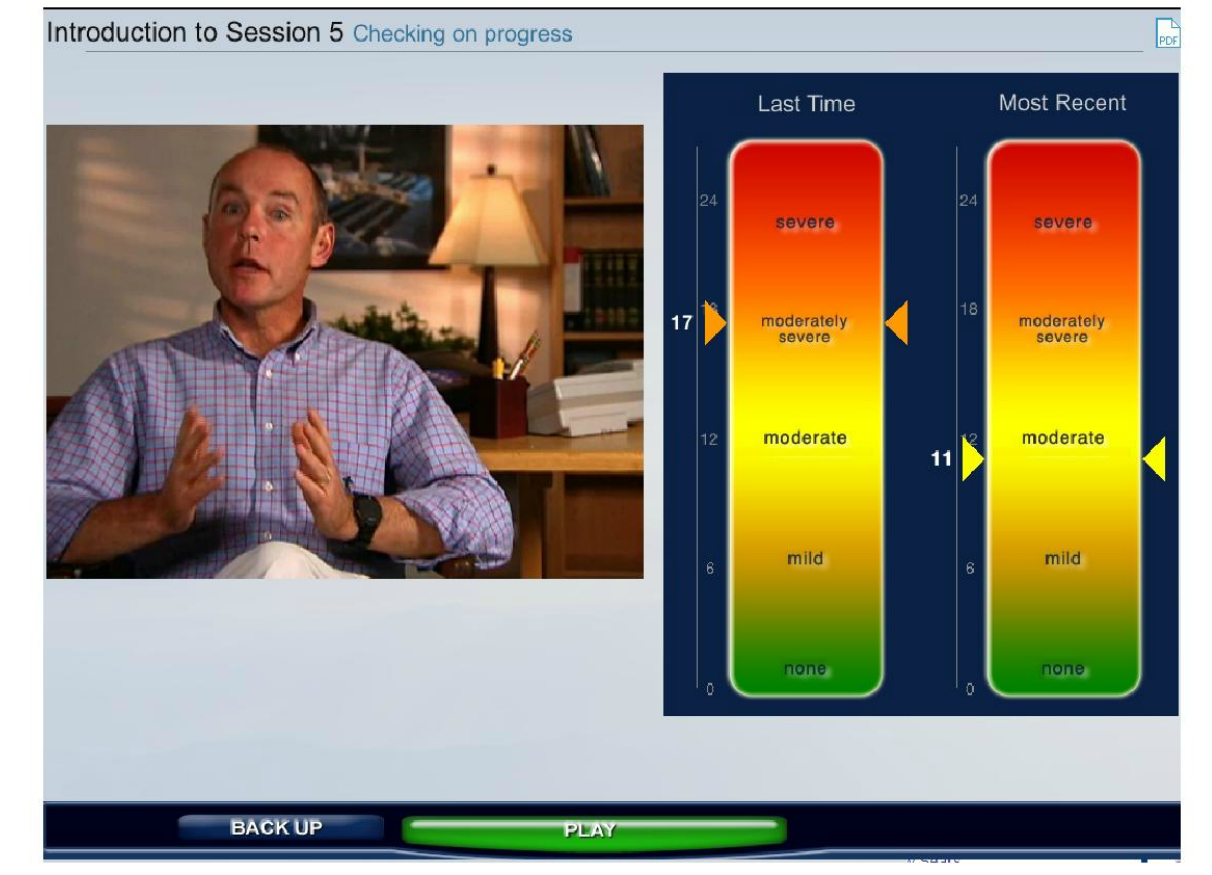
Figure 1. Virtual therapist discusses the Patient Health Questionnaire-9 (PHQ-9) results with the user. Information is provided both graphically and on